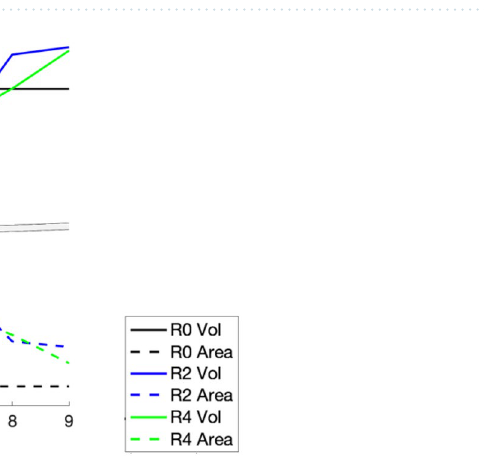
Figure 4. Visual representation of the temperature distribution in the original (top) and optimized (bottom) cores. The left two figures present a radial slice at an axial location of 38.7 cm out of a total core height of 80 cm. The right two figures present an axial slice through the core. Created using MATLAB R2020b, www. mathw orks. com.